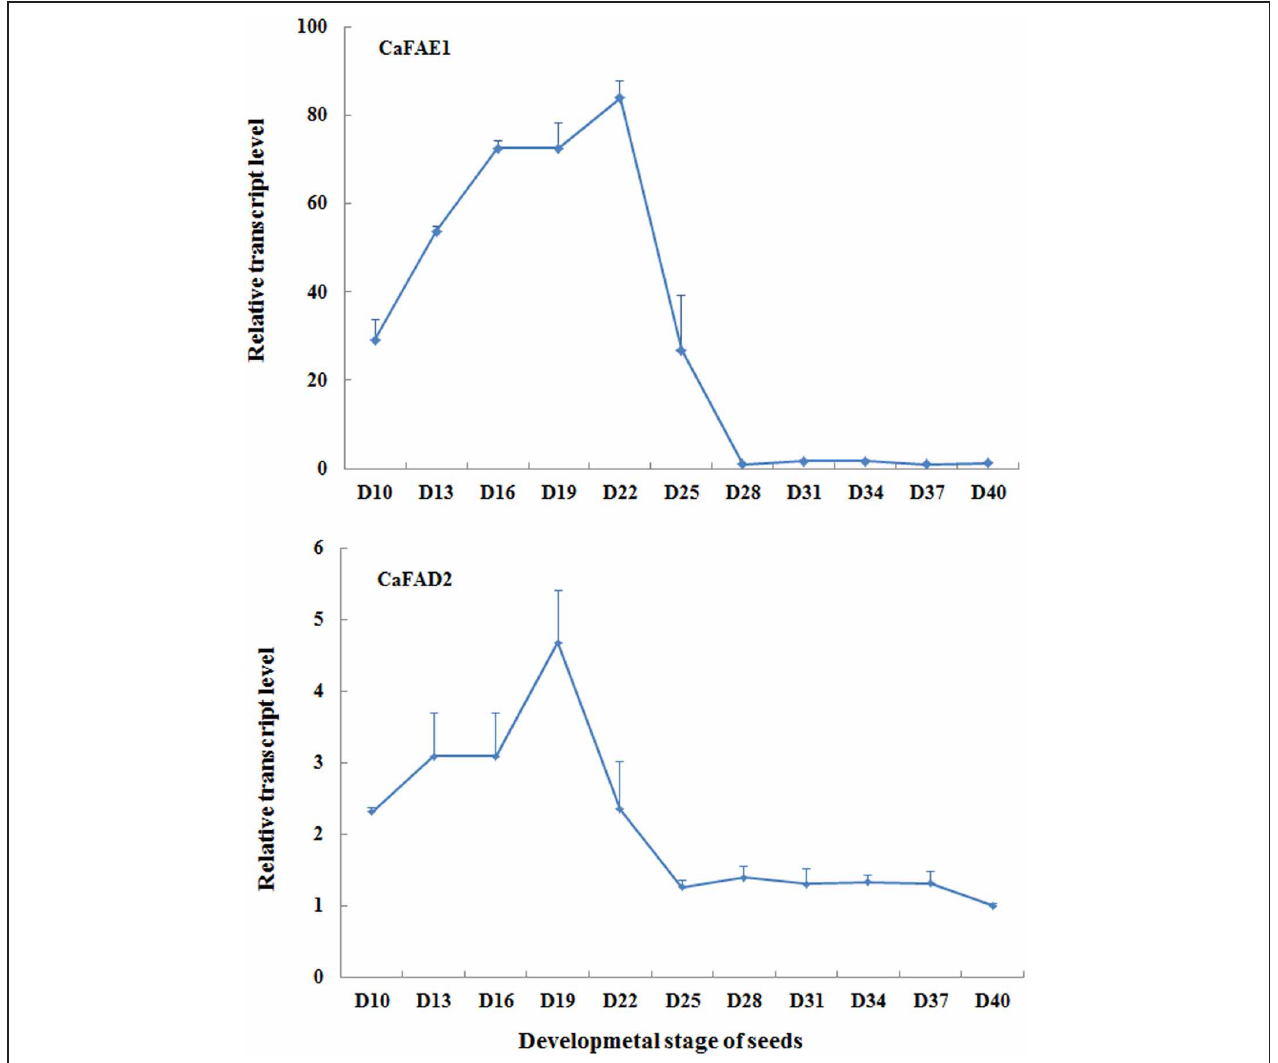
FIGURE 7 | The qRT-PCR results showing the relative expression levels of CaFAE1 And CaFAD2 mRNA during the seed development. D, days after flowering. Data is the average of three biological replicates for each time point.